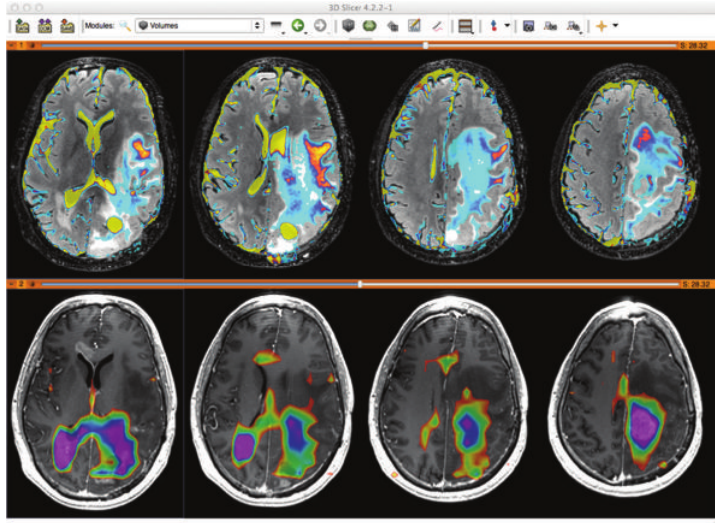
Figure 9: CNI metabolite maps (bottom color overlay) derived from MRSI data in SIVIC are exported as standard DICOM MR Image Storage SOP instances, which can be loaded into 3D DICOM image analysis software packages (shown here in 3D Slicer). Derived maps are thus amenable to multimodal analysis. The top panel shows ADC maps (color) on FLAIR images. The bottom panel shows the same anatomical locations on a T1 contrast enhanced image.